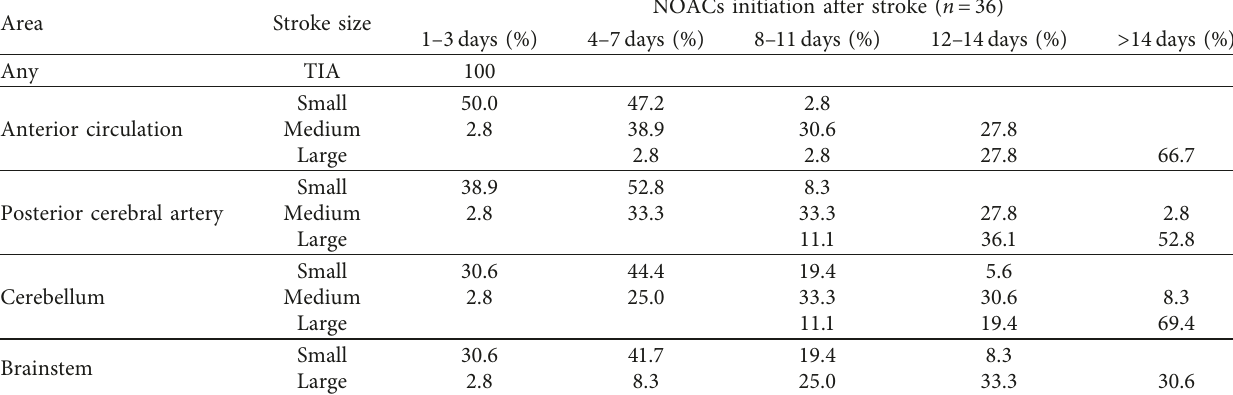
Table 1: Time of initiation of NOACs after nvAF-related stroke based on stroke size and location. Area